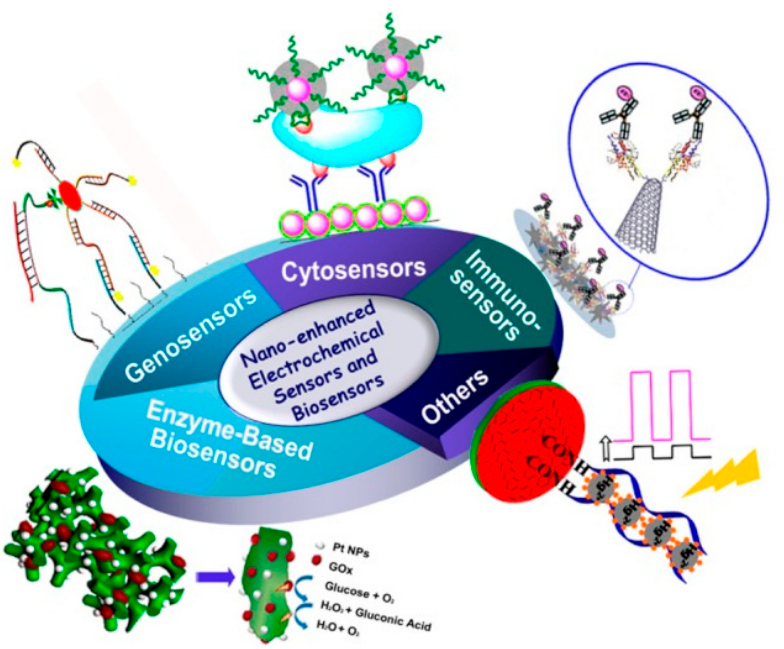
Figure 1. Distinct strategies for the electrochemical detection of H 2 O 2 including Cyto-biosensors, Immuno-biosensors, Enzymatic and non-enzymatic biosensors. Figure reproduced with permission from [46]. Copyright 2014. American Chemical Society (Washington, DC, USA).